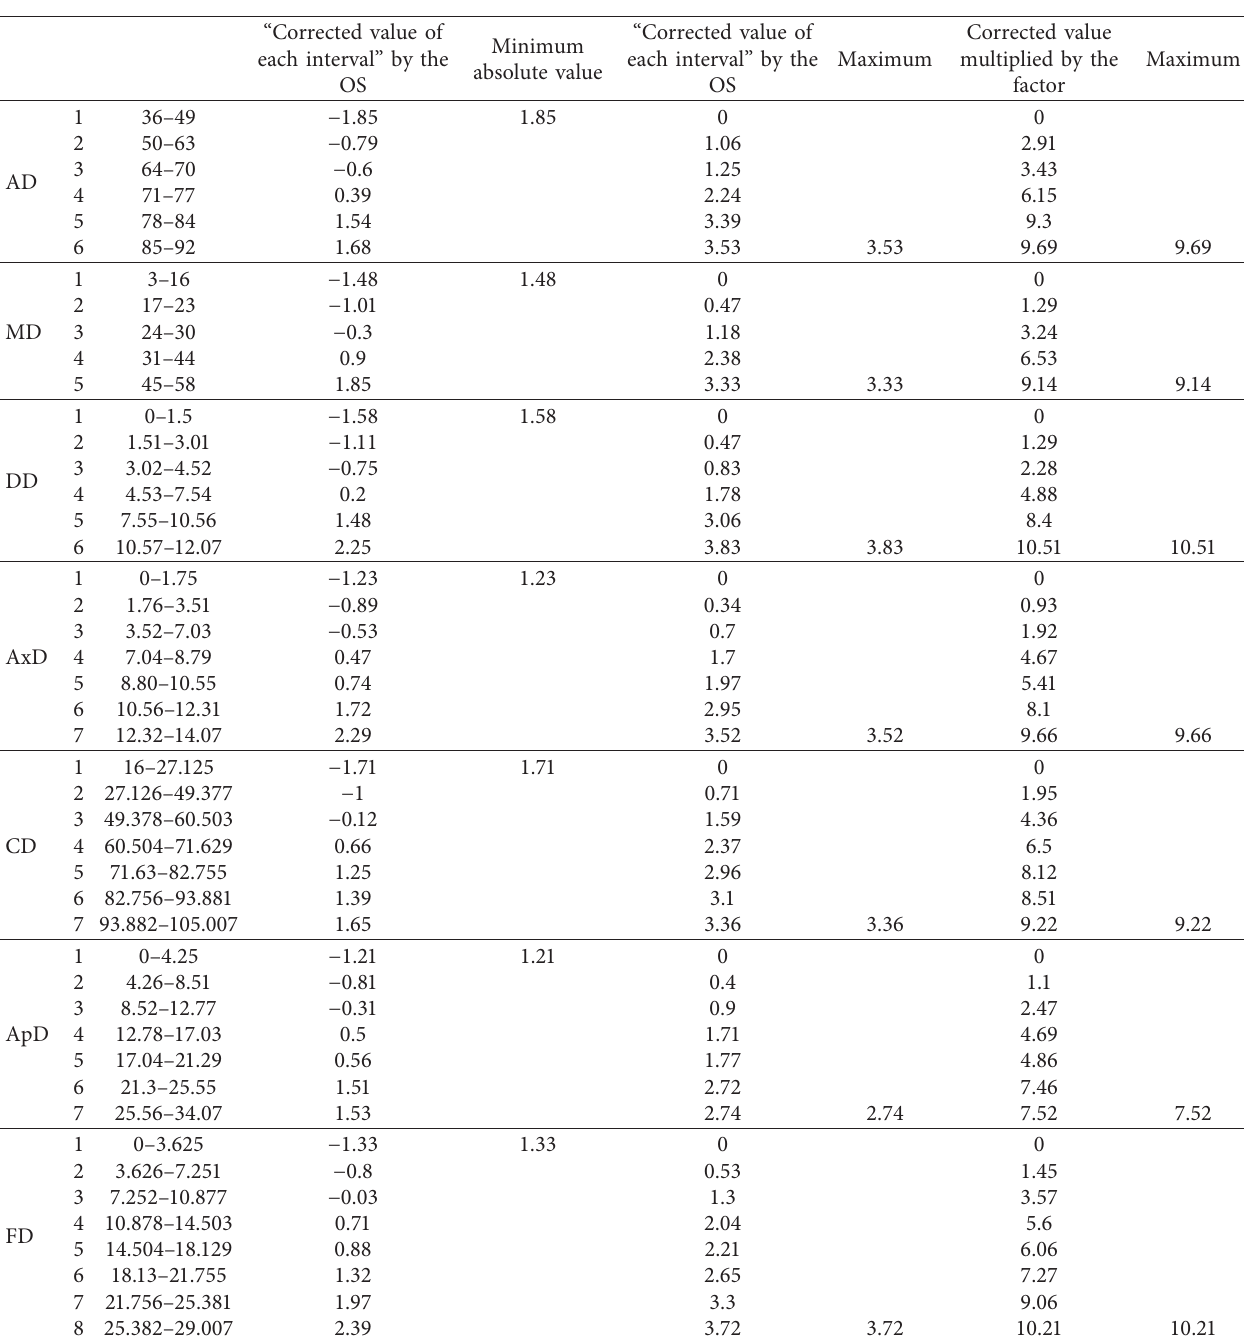
Table 2: Transformation with the